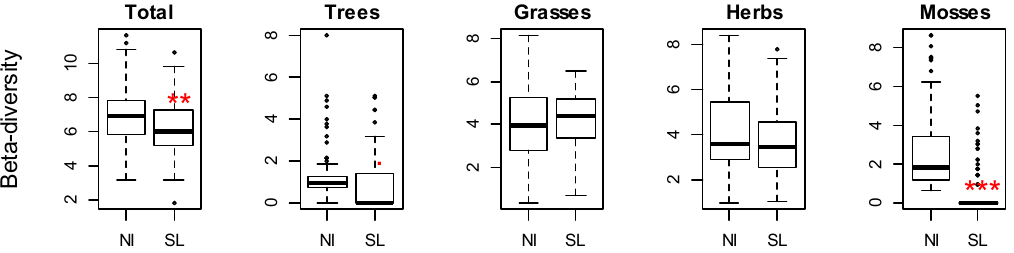
Figure 4. Boxplot comparisons of beta diversity for all species pooled together (i.e., Total), for tree species, and for individual plant functional groups for both NI and SL sites (statistical significance: “***” p < 0.001, “**” p < 0.01, “.” p < 0.1, “ ” not significant). NI and SL significantly differed in species composition ( r 2 = 0.203; p < 0.001), as both communities were distinctively distributed at the opposite site of the ordination space (Figure 5). Structurally diverse downed stems, branches, and other types of deadwood created the heterogeneity of habitats on the NI site. Species such as Oxalis acetosella (L.) that are typical for forest understorey dominated the vegetation composition on the NI site along with naturally regenerating spruce. Moss communities formed by Dicranum sp., Hypnum sp., Plagiomnium sp., Pleurozium sp., Polytrichum sp., and Sphagnum sp. were recorded to be highly